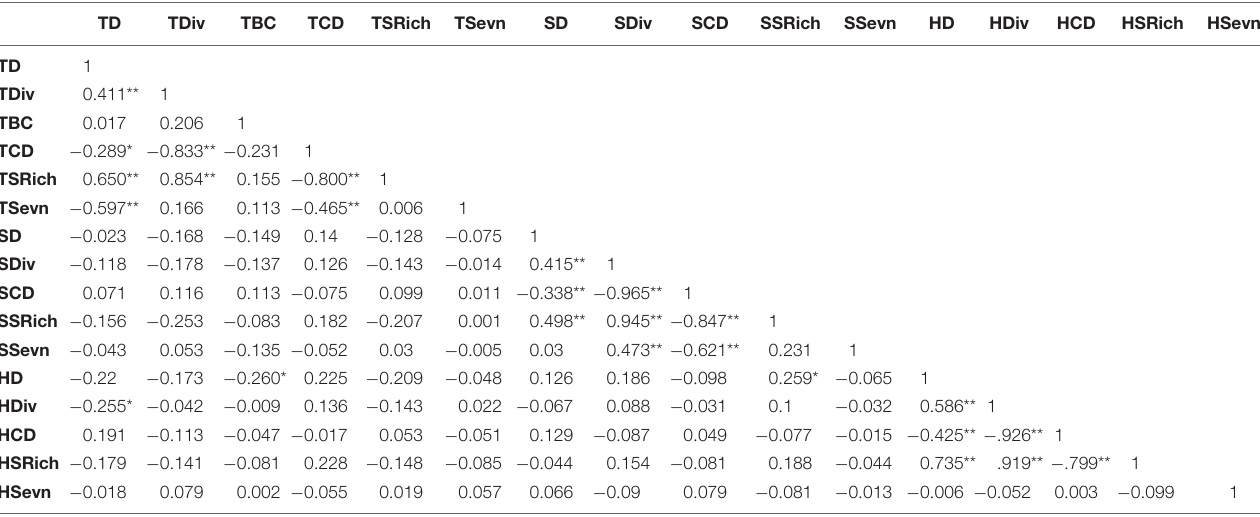
TABLE 3 | Pearson correlation in between the different biodiversity parameters of home gardens ( N =